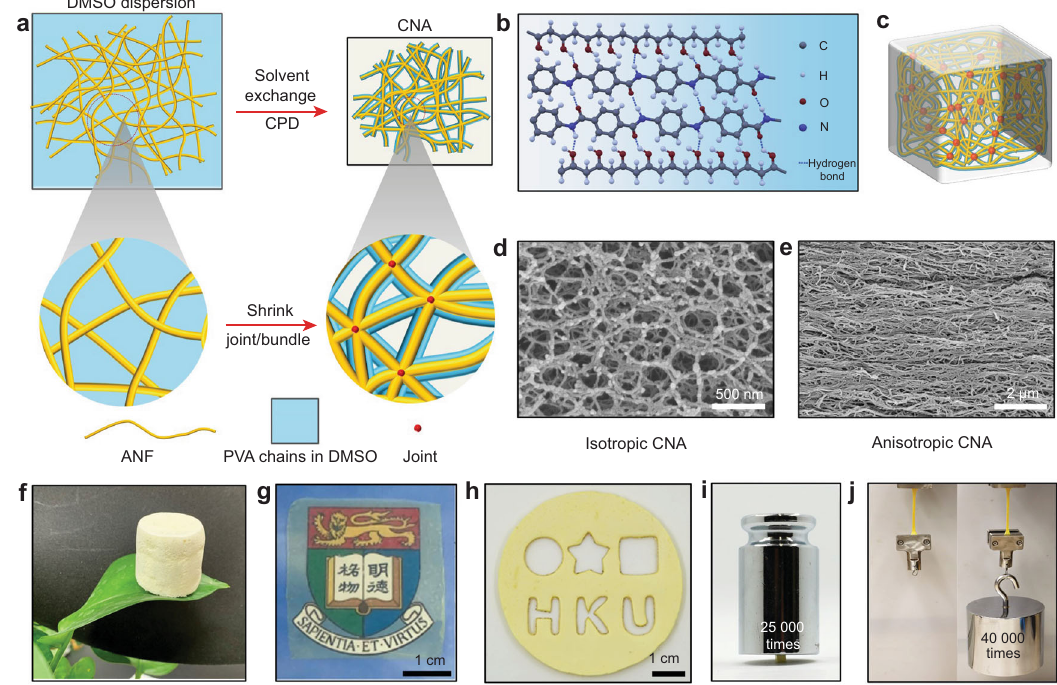
Fig. 1 Design and architecture. a Schematics of the assembly process of CNA. b A schematic of intermolecular interactions between ANF and PVA involved in CNAs. c A schematic of CNA involving bundling and jointing of fi brils in the 3D network. d, e SEM images of an isotropic CNA ( d ) and a highly oriented anisotropic CNA ( e ). f A photograph of a bulk CNA sample with a density of 0.02 g cm − 3 . g A photograph of a CNA membrane with semi- transparency. h A CNA sample patterned with infrared laser machining. i , j Photographs of CNA samples under compression ( i ) and tension ( j ).